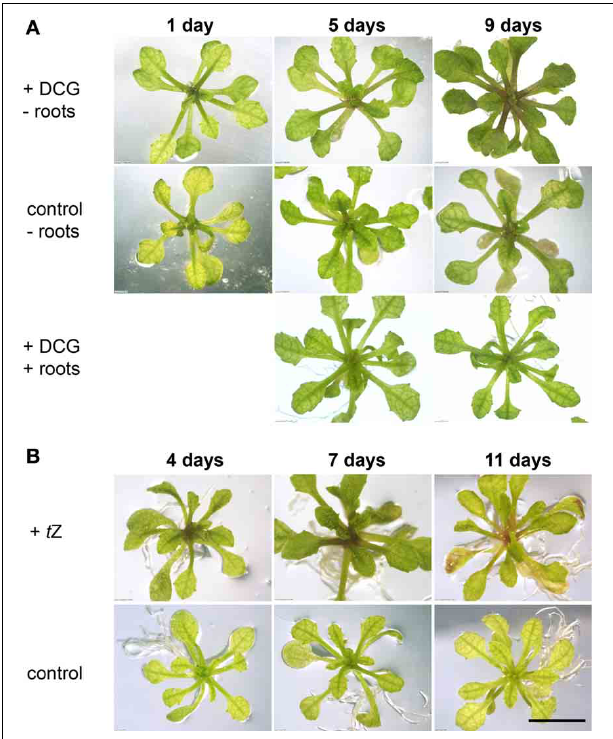
FIGURE 5 | Feeding of cue1-1 with DCG (A) or t Z (B) compared to an unfed control. Plants were grown on ½MS agar for four weeks and were then transferred to a medium containing either 20 μ M DCG or 1 μ M t Z. DCG rescued the reticulate leaf phenotype only if the roots were excised (-roots) and the rosettes were placed directly with their cut edges on the agar plates, but not intact plants ( + roots). The bar indicates a length of 1cm.